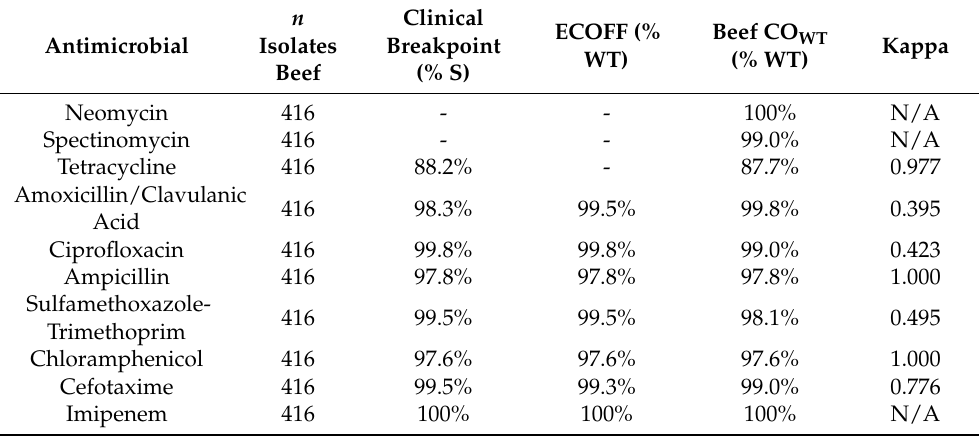
Table 4. Prevalence of antimicrobial susceptible (S) and wild type (WT) E. coli isolated from beef cattle using clinical breakpoints, ECOFFs and the NRI method. n Antimicrobial